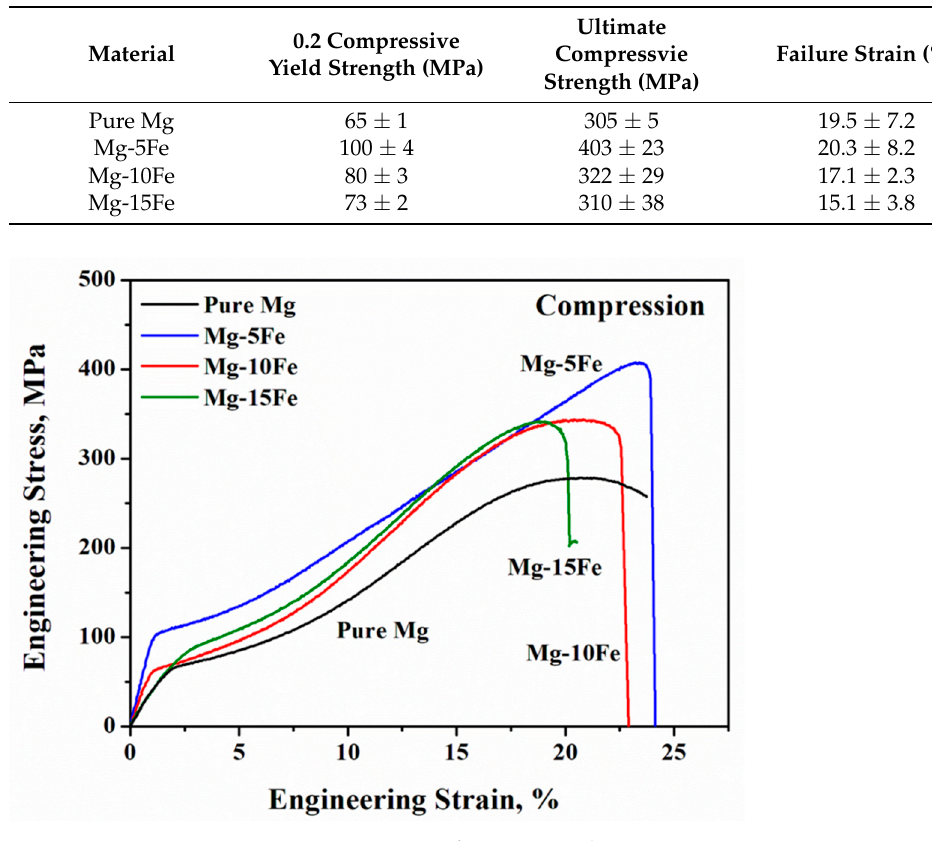
Figure 6. Compression stress–strain curves of pure Mg and Mg-Fe